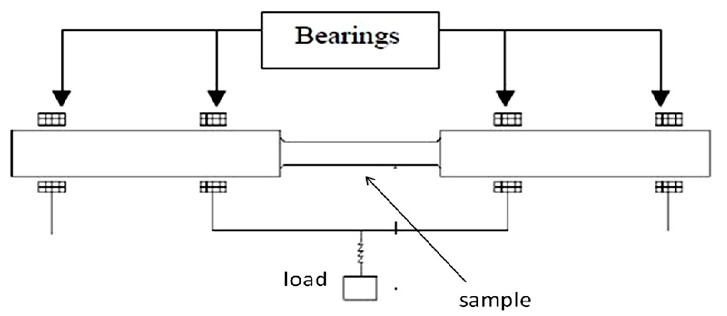
Figure 1: basic design of a R.R. Moore fatigue testing